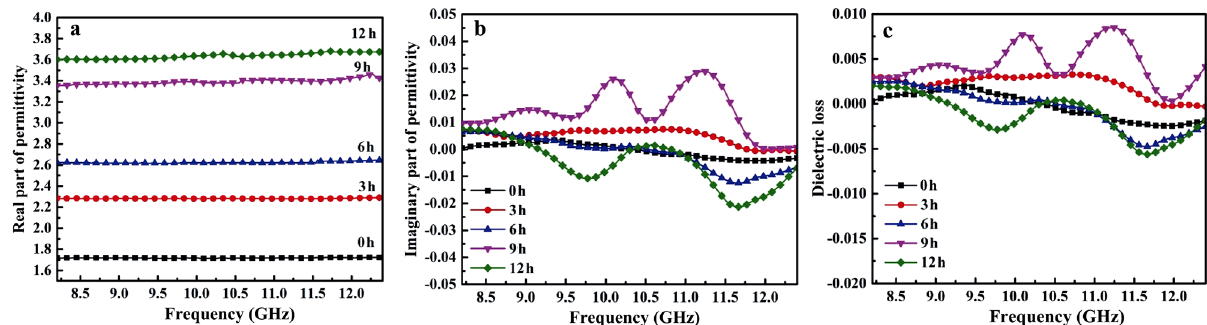
Fig. 5 Dielectric properties in 8.2–12.4 GHz of porous Si 3 N 4 –Si 3 N 4 composite ceramics as a function of deposition time: (a) the real part of permittivity, (b) the imaginary part of permittivity, and (c) dielectric